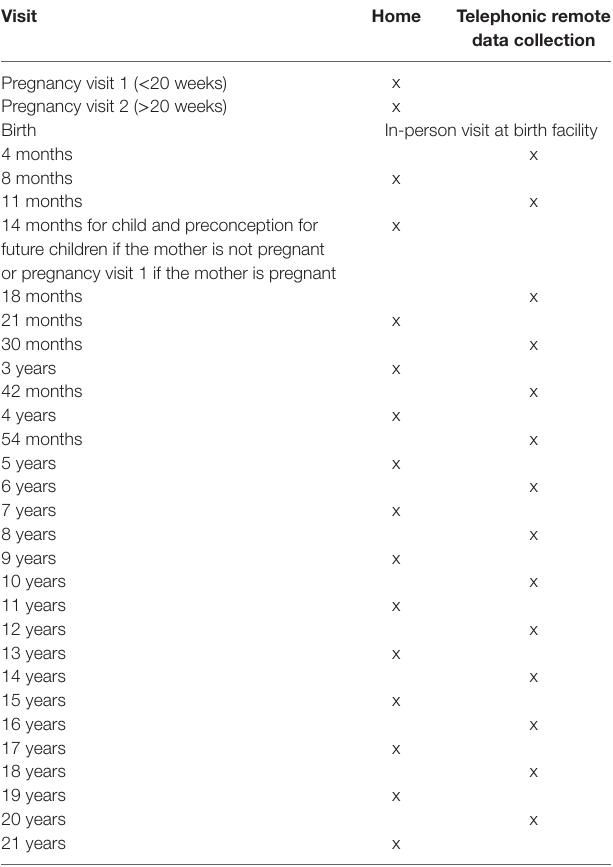
TABLe 3 | National Children’s Study Proposed Visit Schedule from